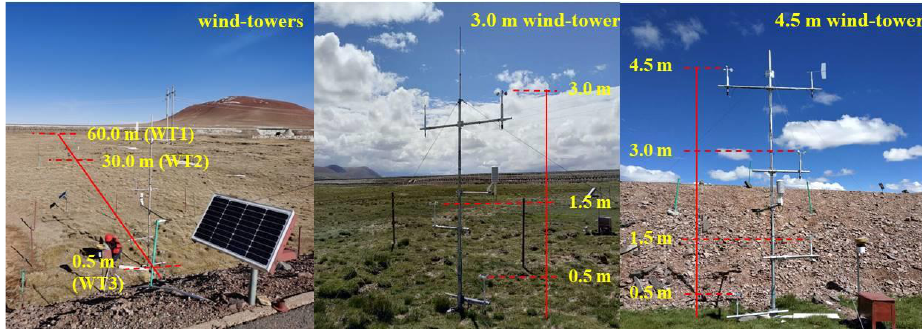
Figure 2. Pictures and illustrations of the wind-towers in the field.